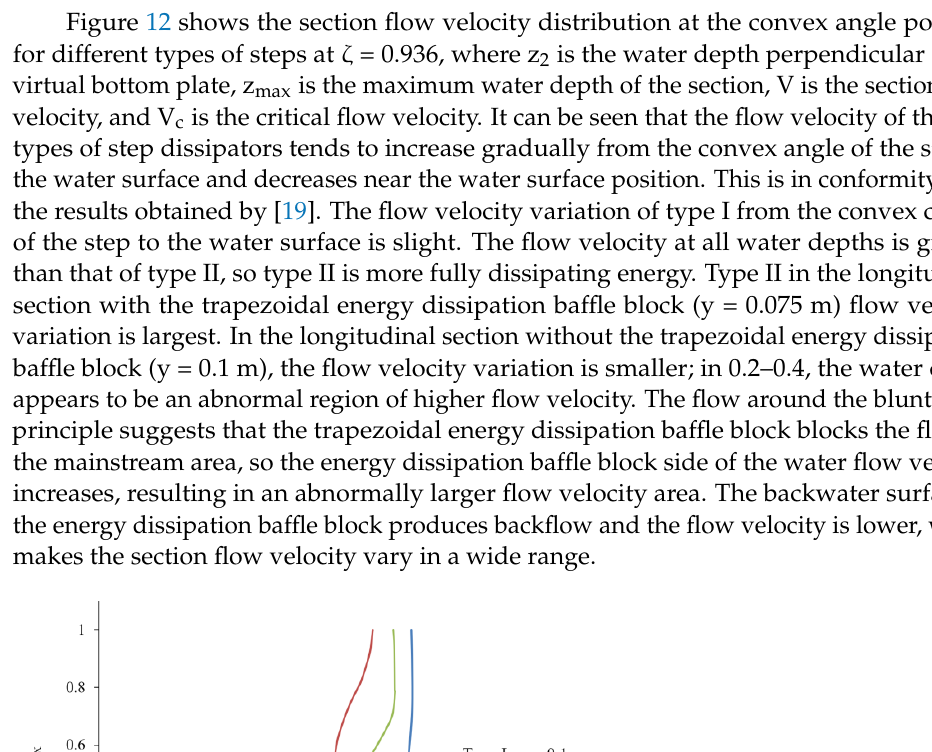
Figure 11. Cloud diagram of the pressure distribution in the type II section at ζ = 0.936.